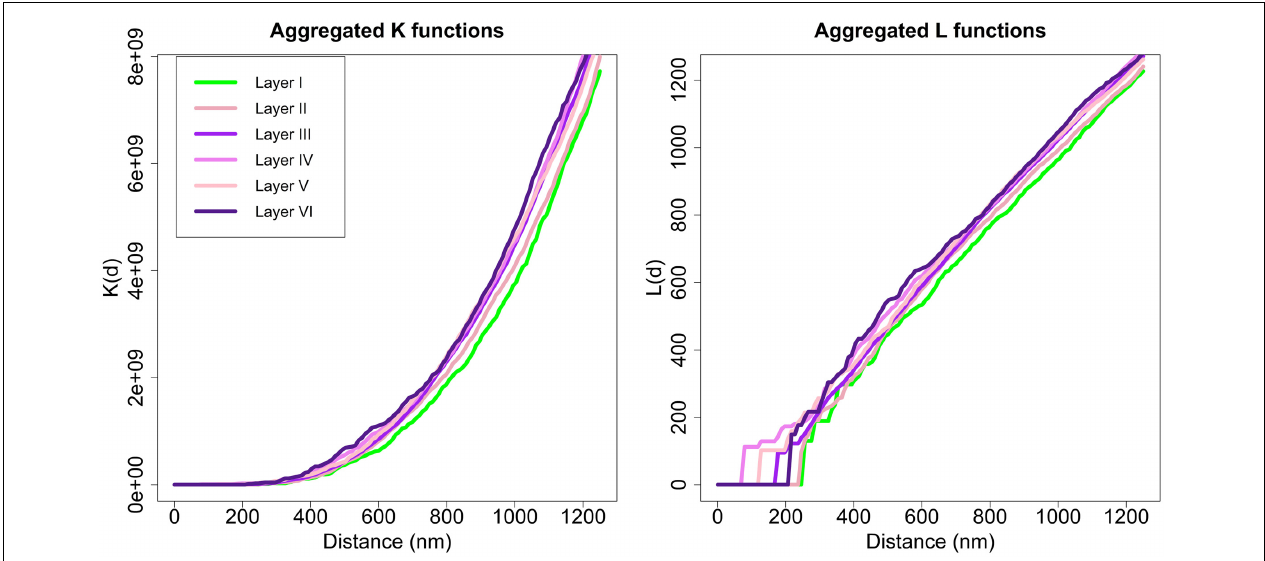
FIGURE 8 | Aggregated K and L functions for each layer. The Diggle test found no significant differences between K functions of layers II, III, IV, V, and VI (shown in different shades of violet). Layer I (green) is significantly different from other layers.